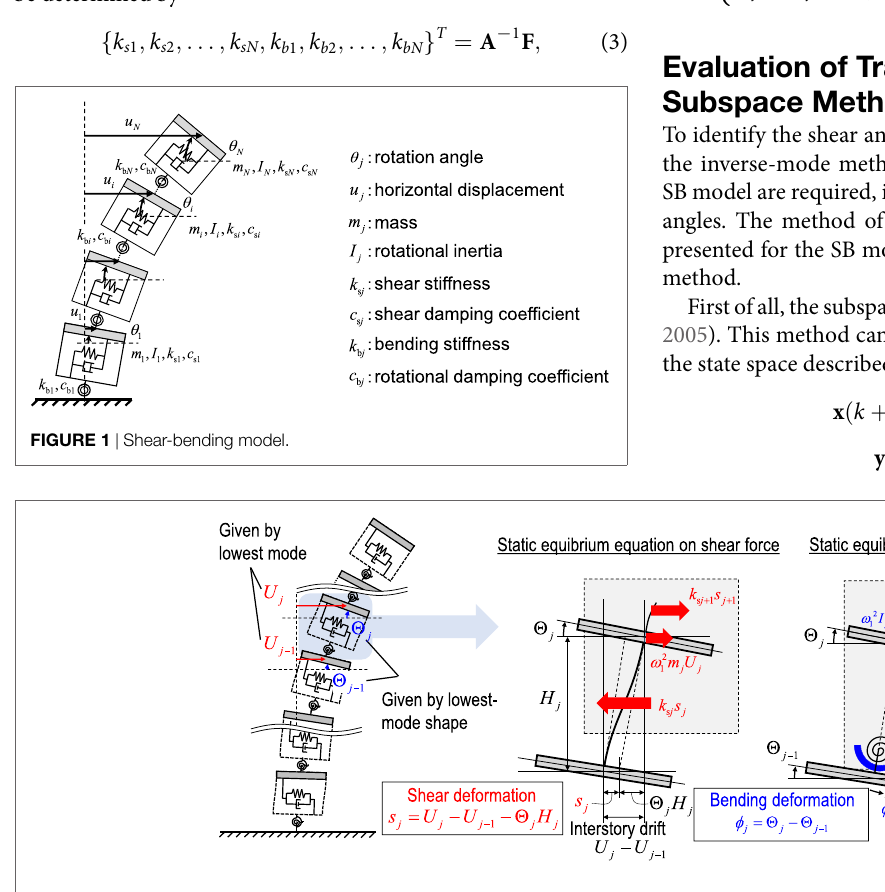
FIGURE 2 | Scheme of inverse-mode method for shear-bending